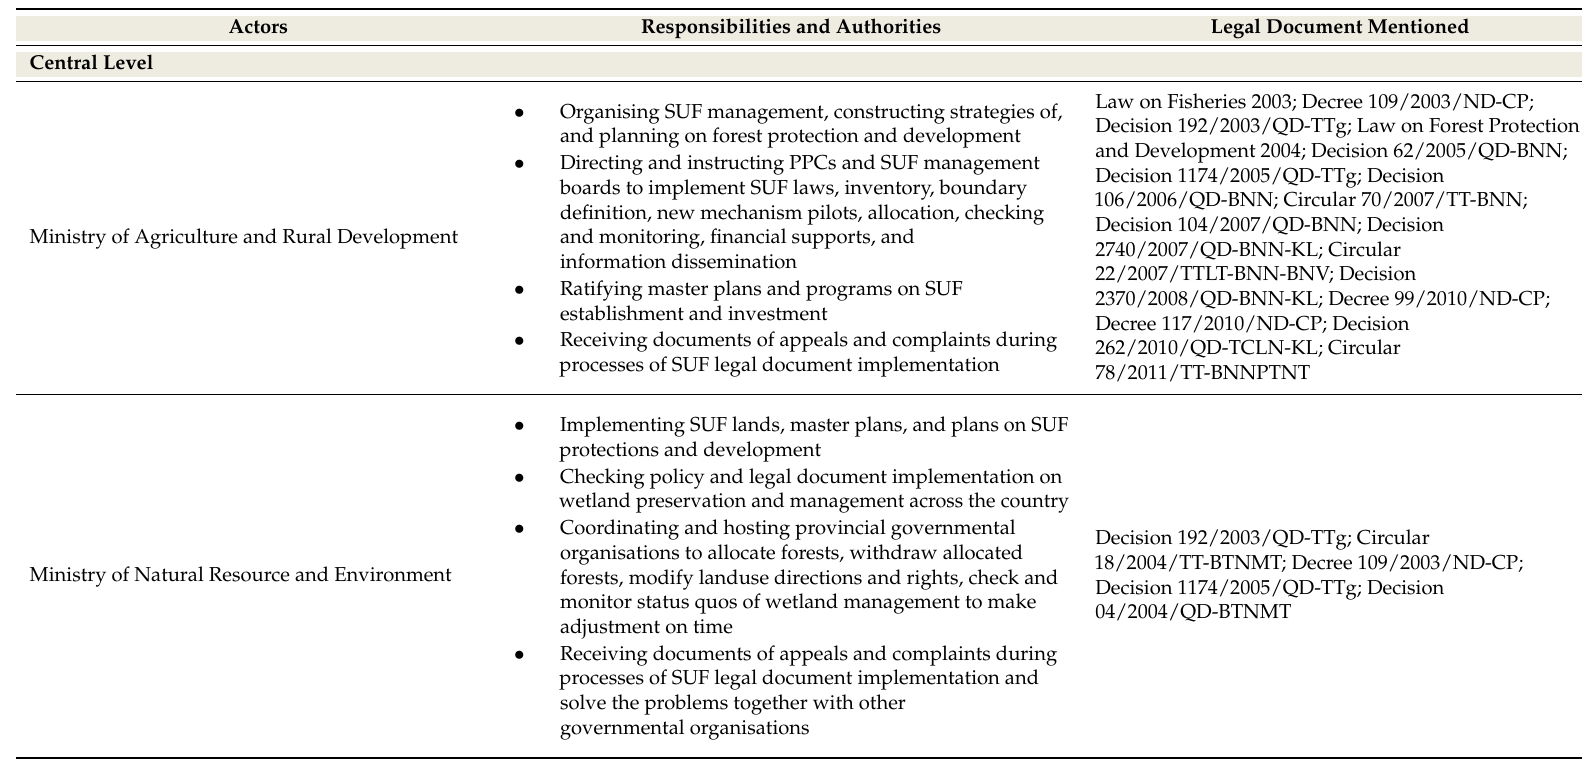
Table A1. A summary of responsibilities and authorities of actors in SUF